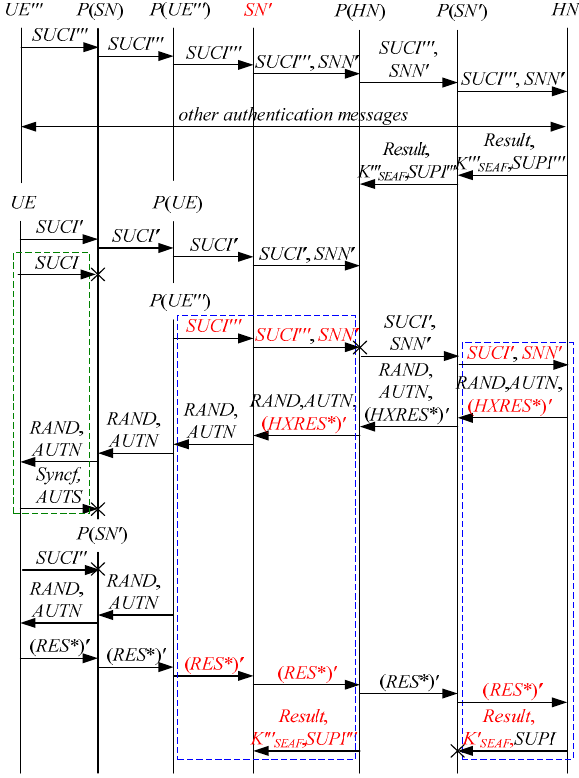
Figure 6. The fifth attack scenario of the 5G AKA protocol.